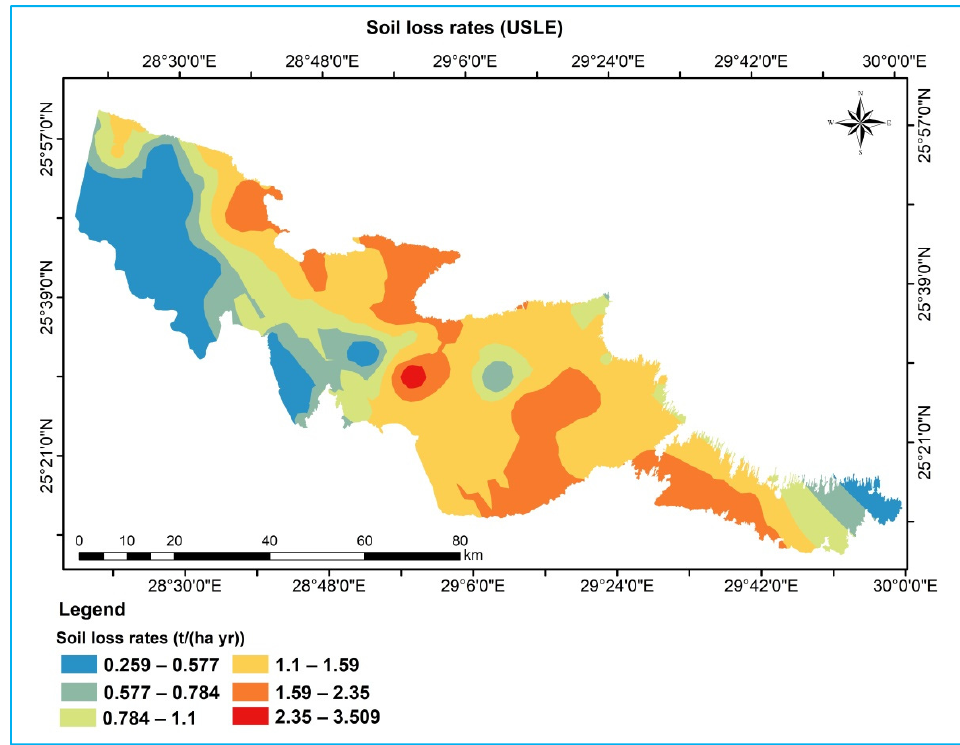
Figure 12. Spatial distribution map of soil loss rates according the USLE model.